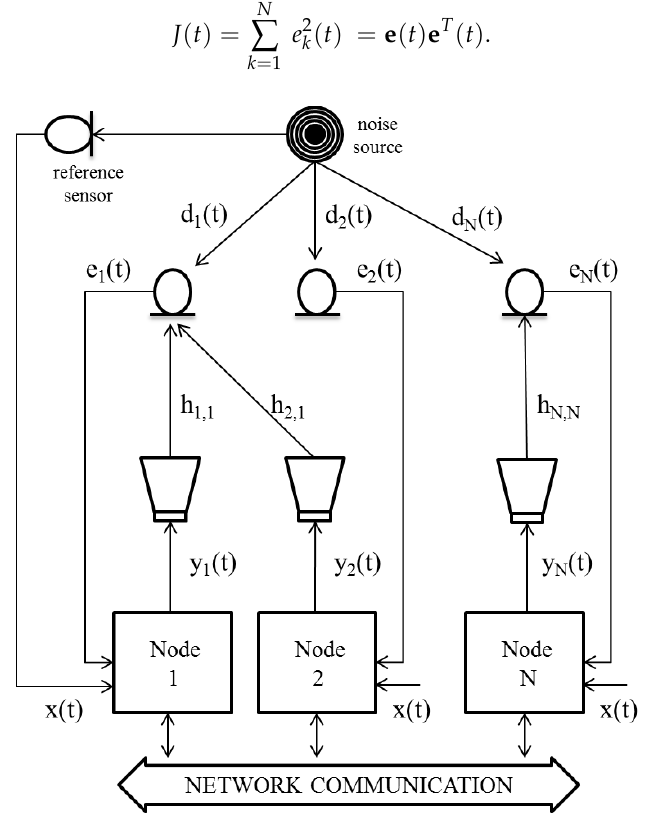
Figure 2. Acoustic Sensor Network (ASN) of N nodes for an ANC